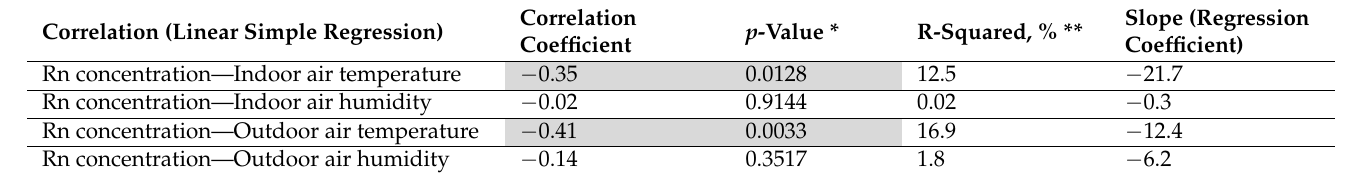
Table 3. Correlation parameters of regression of radon concentration with indoor and outdoor meteorological conditions.